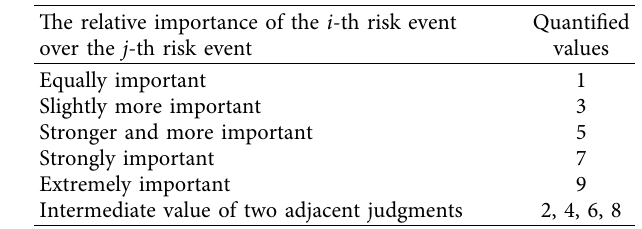
Table 12: Factor score table.